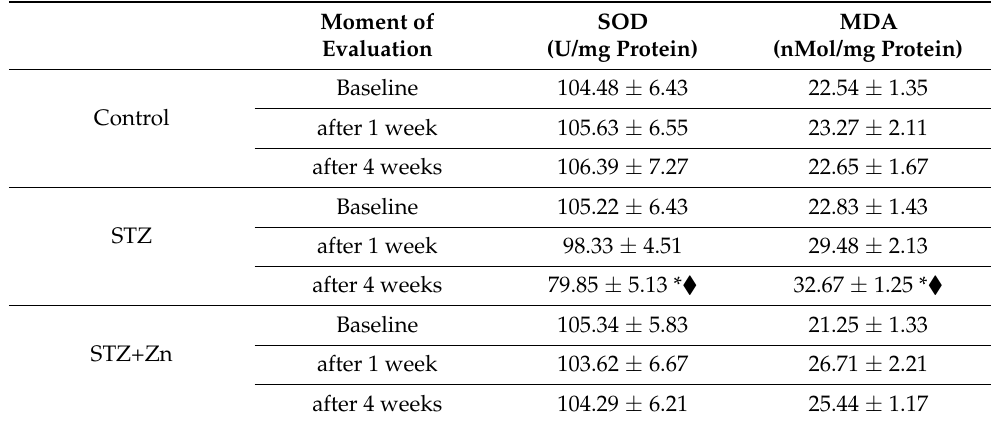
Table 8. The influence of Zn on the activity of SOD and MDA in diabetic rats. The values are presented as mean value ± S.D. for five animals per lot. (SOD—superoxide dismutase, MDA— malondialdehyde). * p < 0.05 versus control; (cid:7) p < 0.05 versus